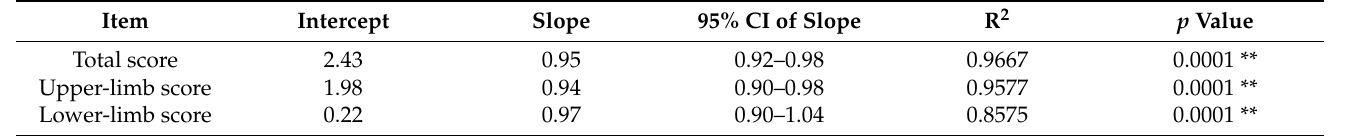
Table 3. Regression analysis parameters of intelligent rehabilitation assessment system score and physician’s FMA